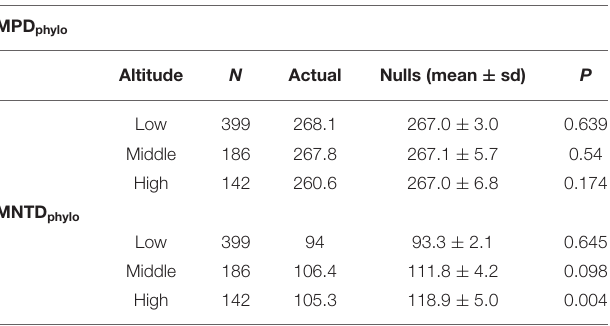
TABLE 2 | Summary of the phylogenetic structure of low, middle and high-altitude species in Taiwan. MPD phylo Altitude N